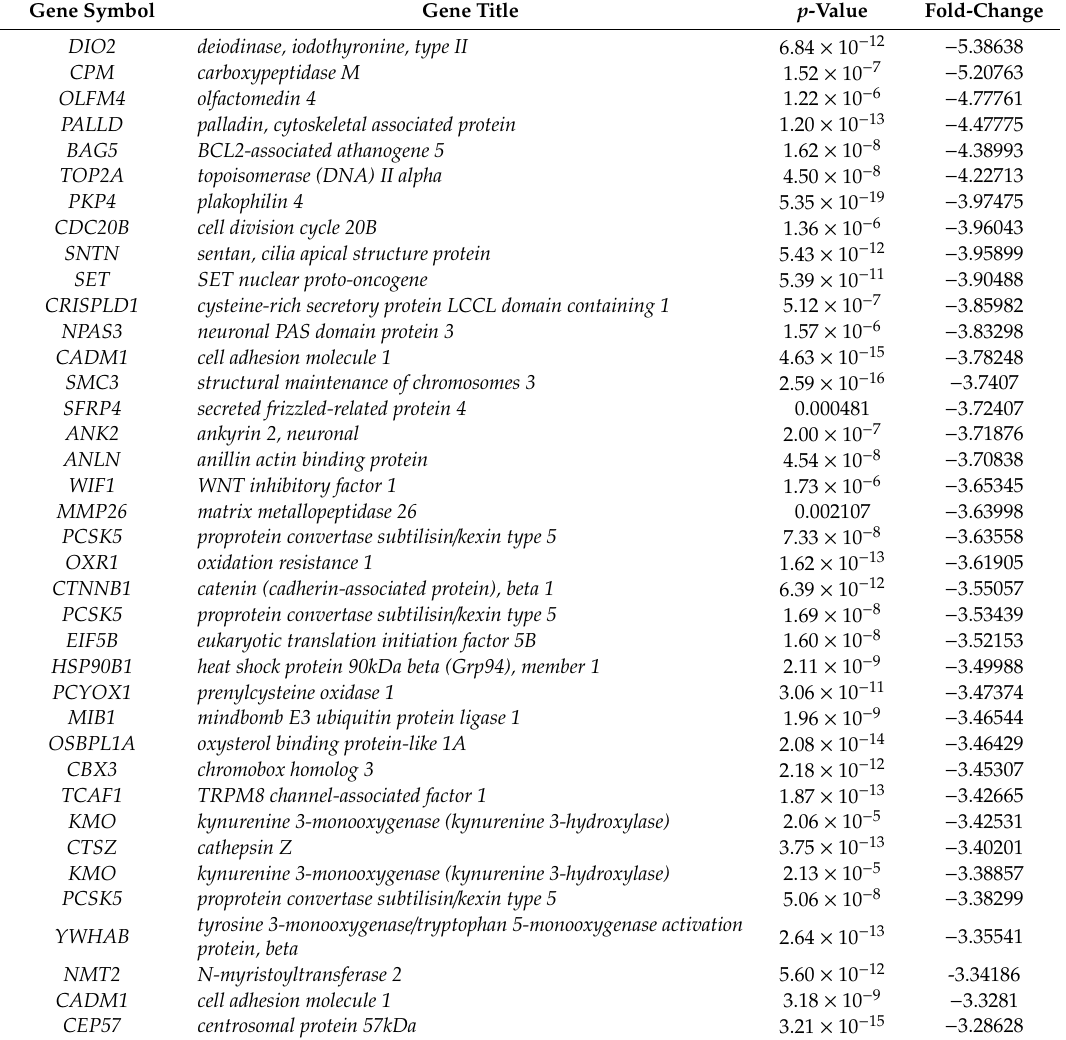
Table 3. The top downregulated di ff erentially expressed genes in meta-analysis of endometriosis.